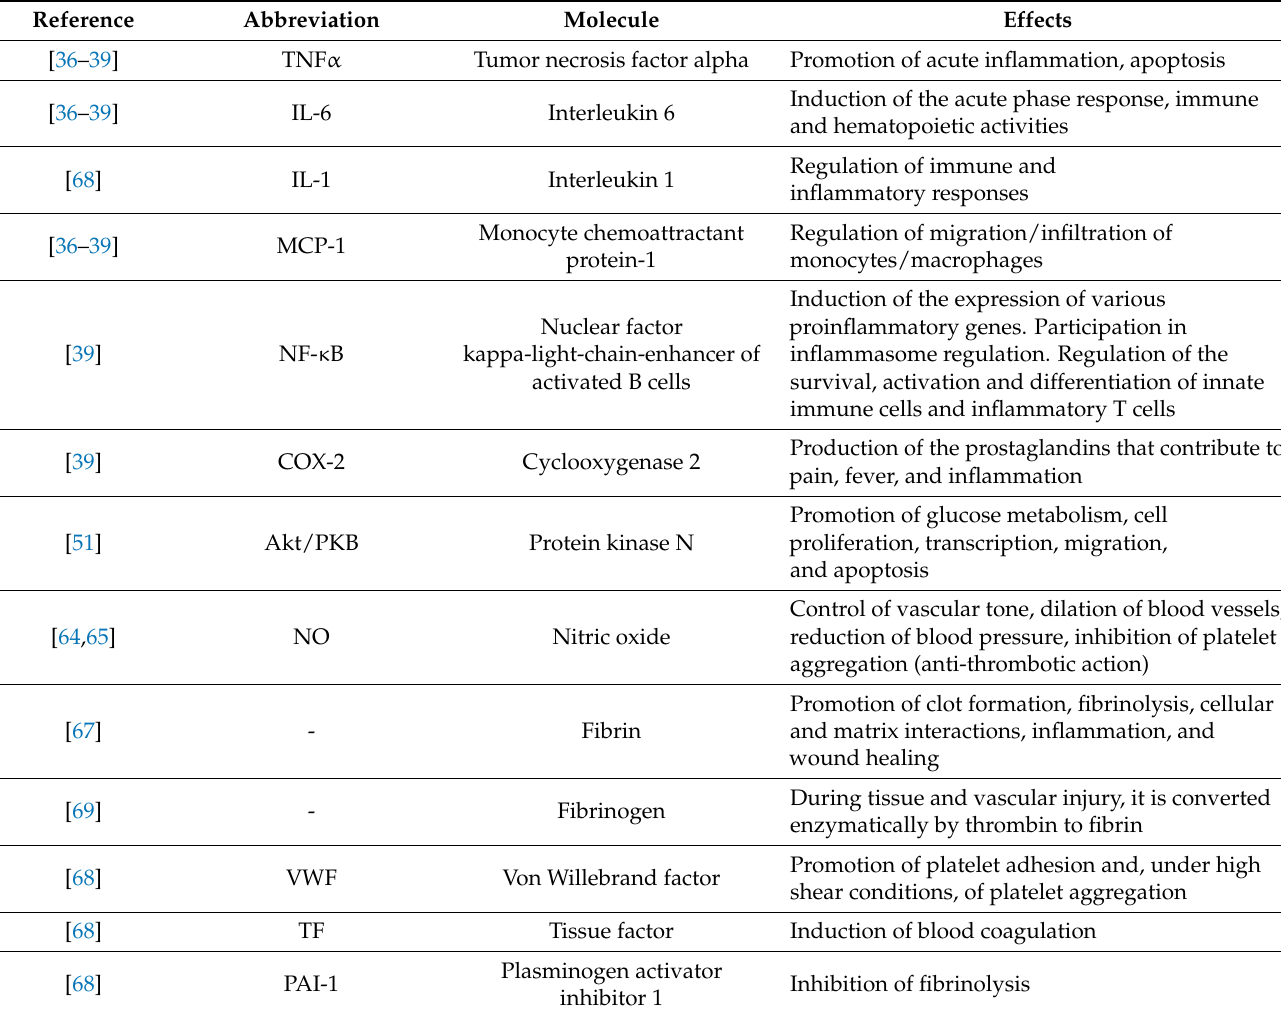
Table 2. List of the molecules cited in the text as involved in the association between exposure to air pollutants and the risk of type 2 diabetes and their main biological